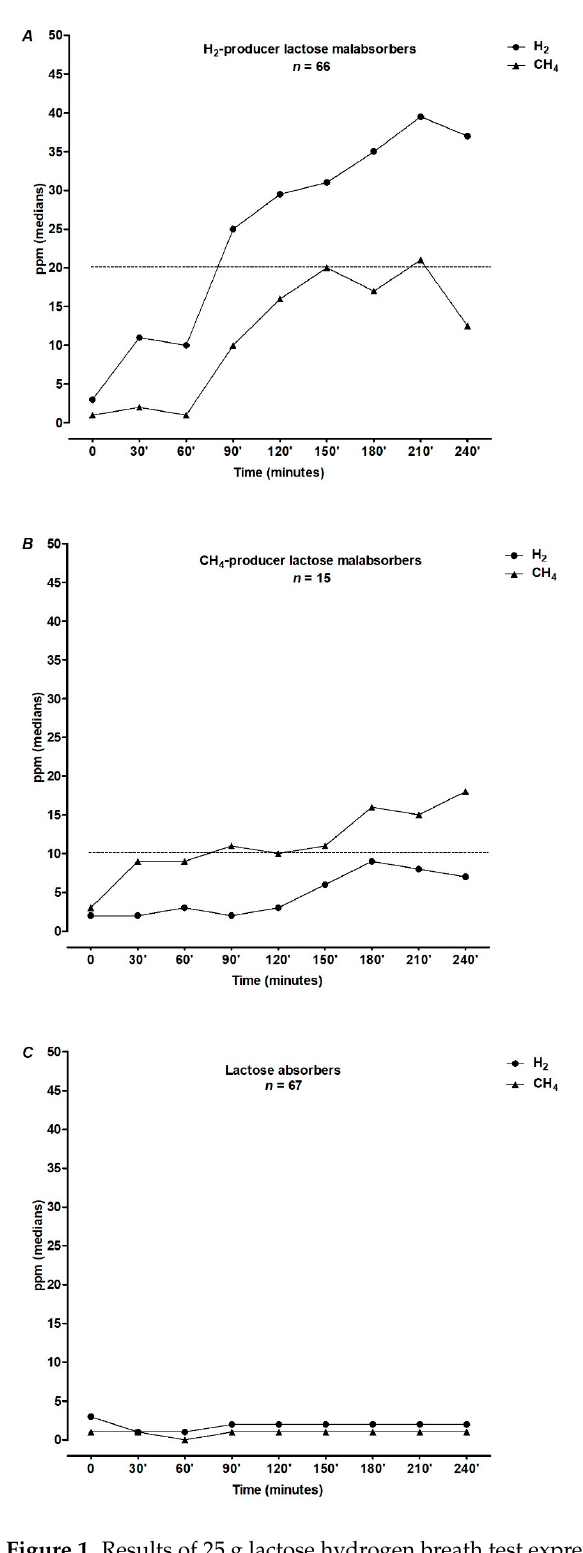
Figure 1. Results of 25 g lactose hydrogen breath test expressed as medians of H 2 and CH 4 excretion in ppm at each time point. The dotted lines indicate, respectively, the currently effective cut-off values of H 2 or CH 4 to diagnose lactose